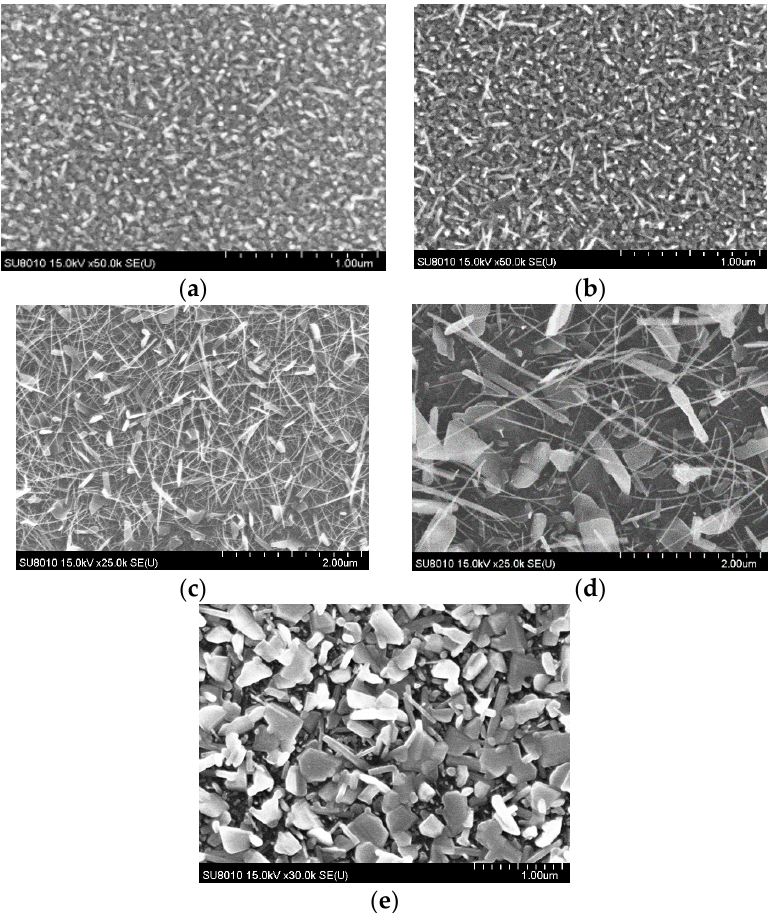
Figure 2. The top view topography of the Fe-doped WO 3 : ( a ) the surface of the film grown at T = 600 °C, ( b ) T = 650 °C, ( c ) T = 700 °C, ( d ) T = 720 °C, ( e ) T = 750 °C.